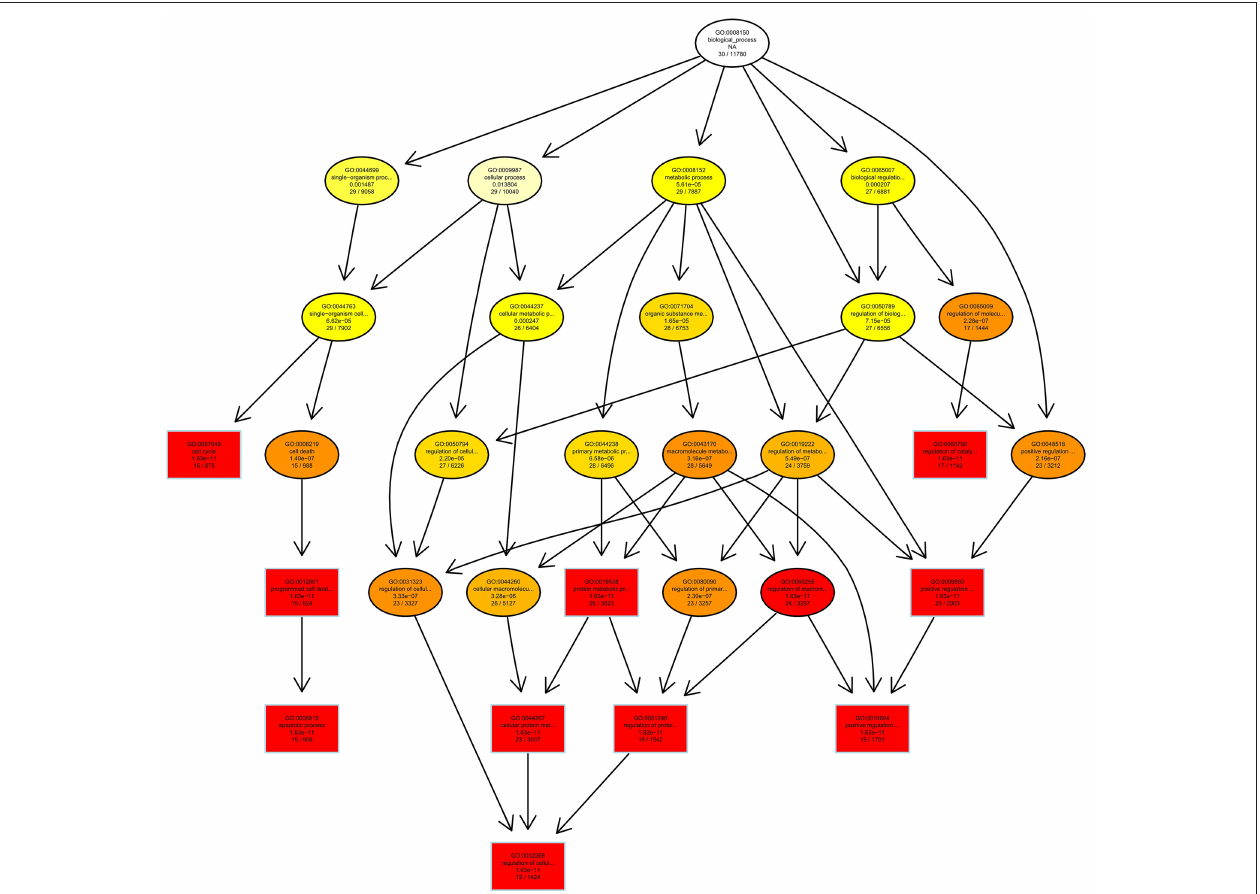
FIGURE 11 | Directed Acyclic Graph of GO enrichment.